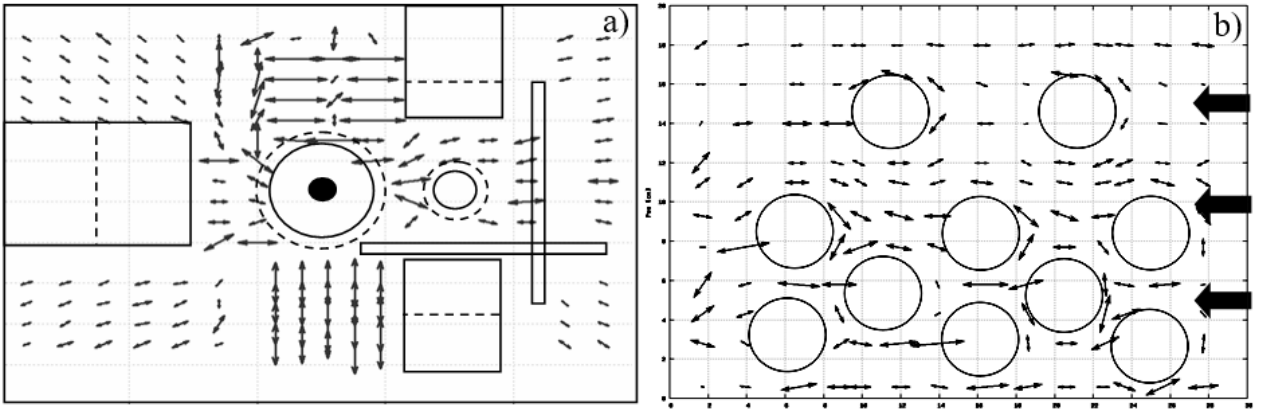
Figure 25. Fibre reinforcement mapping in injection molding specimens of GFRP: polypropylene specimen 160 × 250 × 2 mm 3 ( a ); polyurethane 300 × 200 × 4 mm 3 ( b ) specimen.